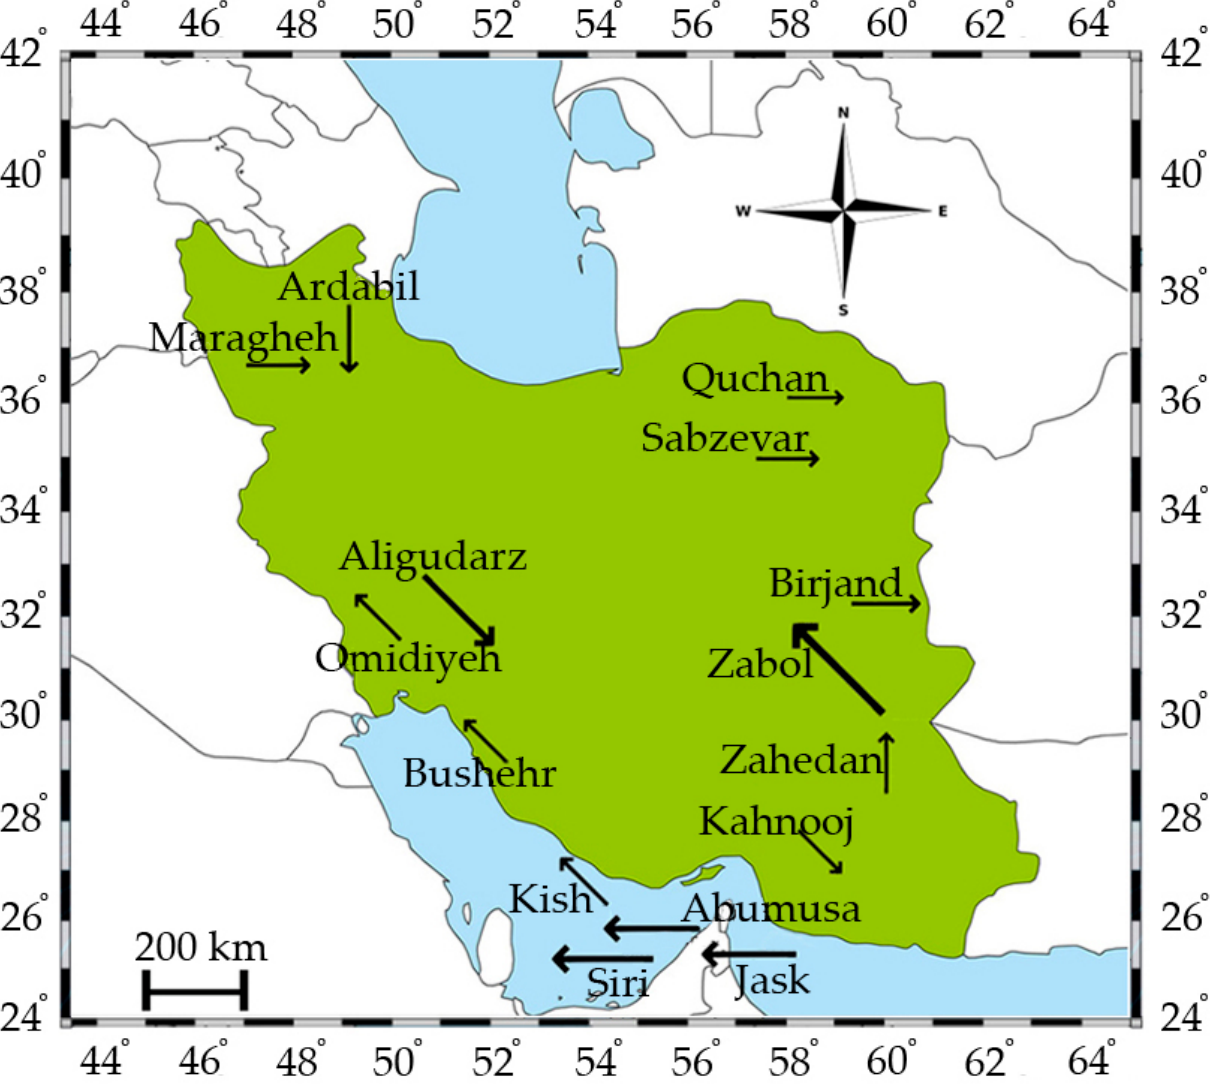
Figure 4. Wind vector field of the first 15 ranked meteorological stations.